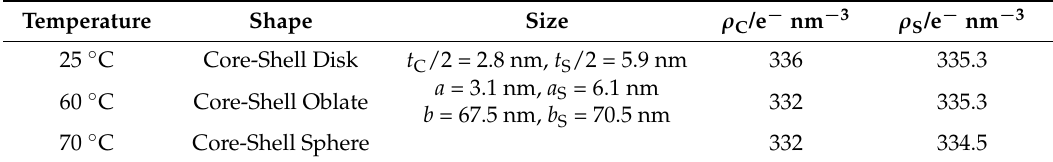
Table 1. Models and adjustable parameters used in fitting analyses for SAXS profiles of PVP- b -PODA micelles.